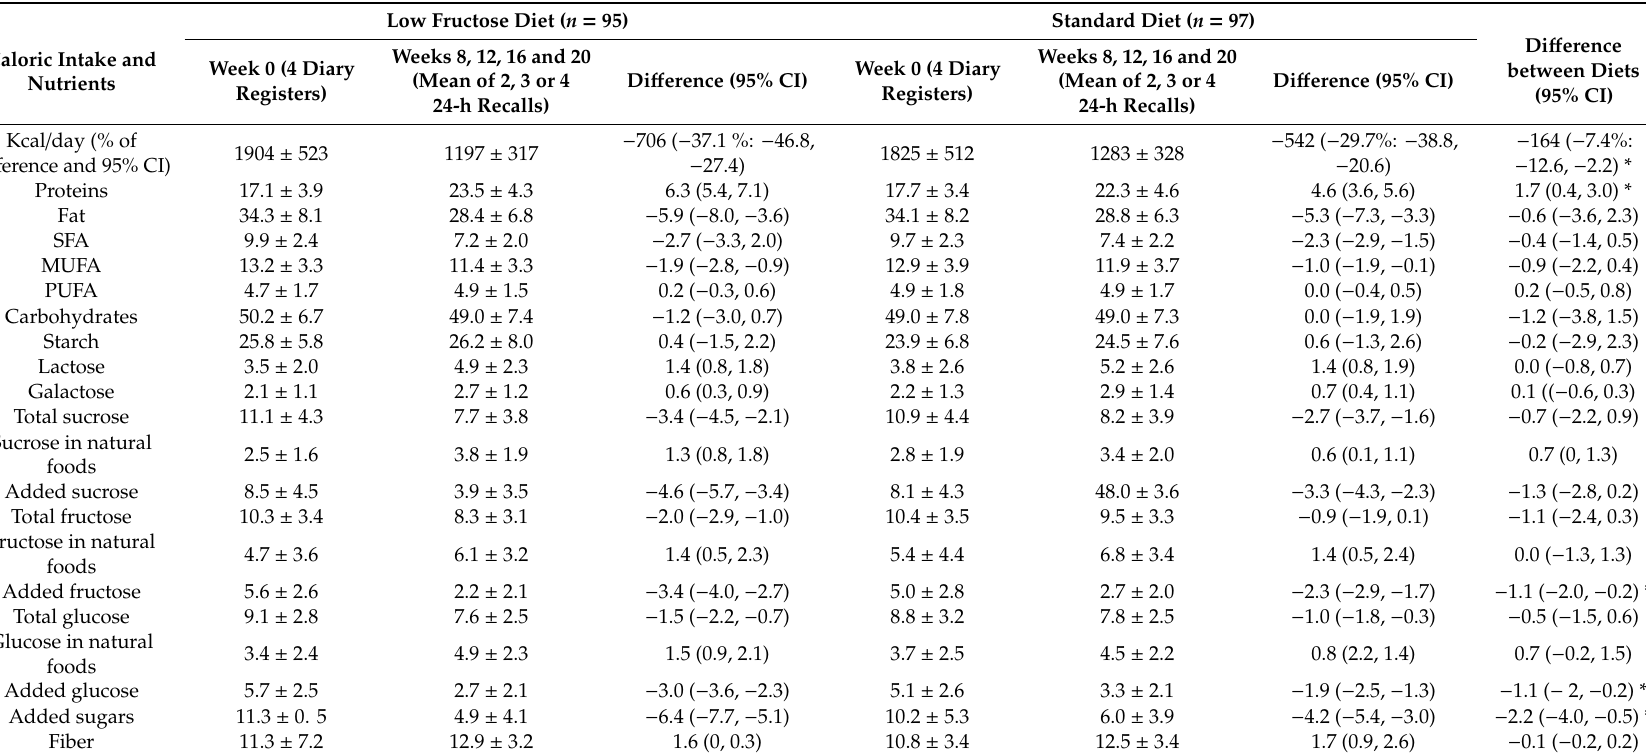
Table 4. Di ff erences in nutrients (% of energy intake) and mean daily calorie intakes in kcal / day between the intermediate weeks (with at least two 24-h recalls) and week